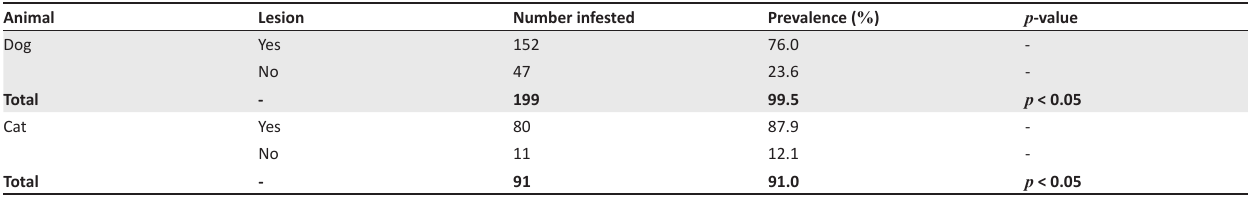
TABLE 6: Association between overall prevalence of ectoparasites and skin lesions amongst animals. Animal